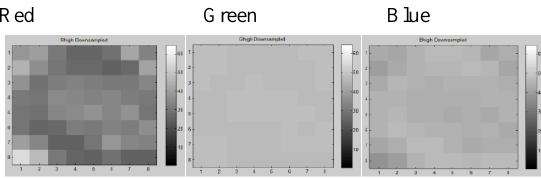
Figure 10. Downsampled 8× 8 pixels multispectral data for red, green and blue channels 3.2.2 Results based on case 2: